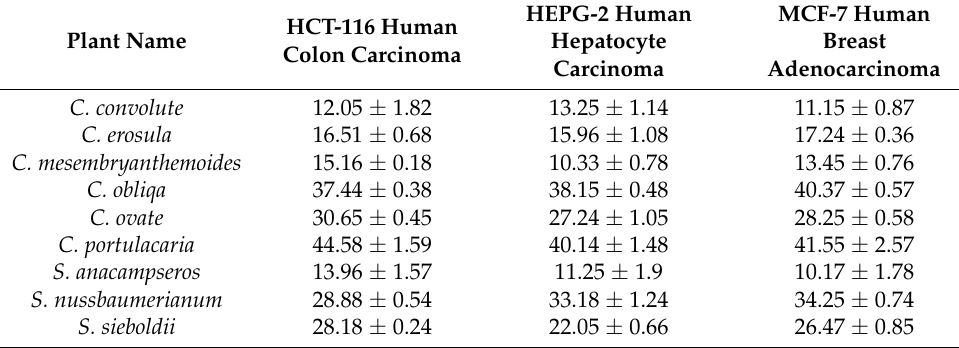
Table 2. IC 50 ( µ g/mL) cytotoxic activities of the examined plants’